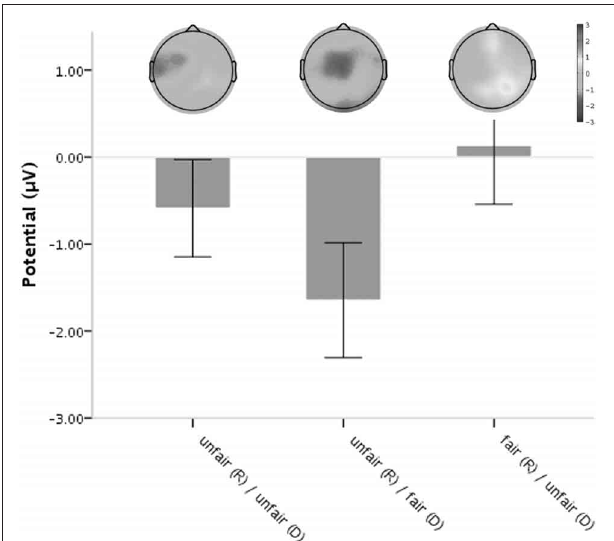
FIGURE 3 | Scalp potential topography of the average voltage differences between equal offers (fair/fair) and the three unequal offers (fair/unfair, unfair/fair and unfair/unfair) for the time point of the MFN (240–340 ms following offer onset). The bar chart depicts the respective mean MFN amplitude values. Error bars indicate 1 SE.